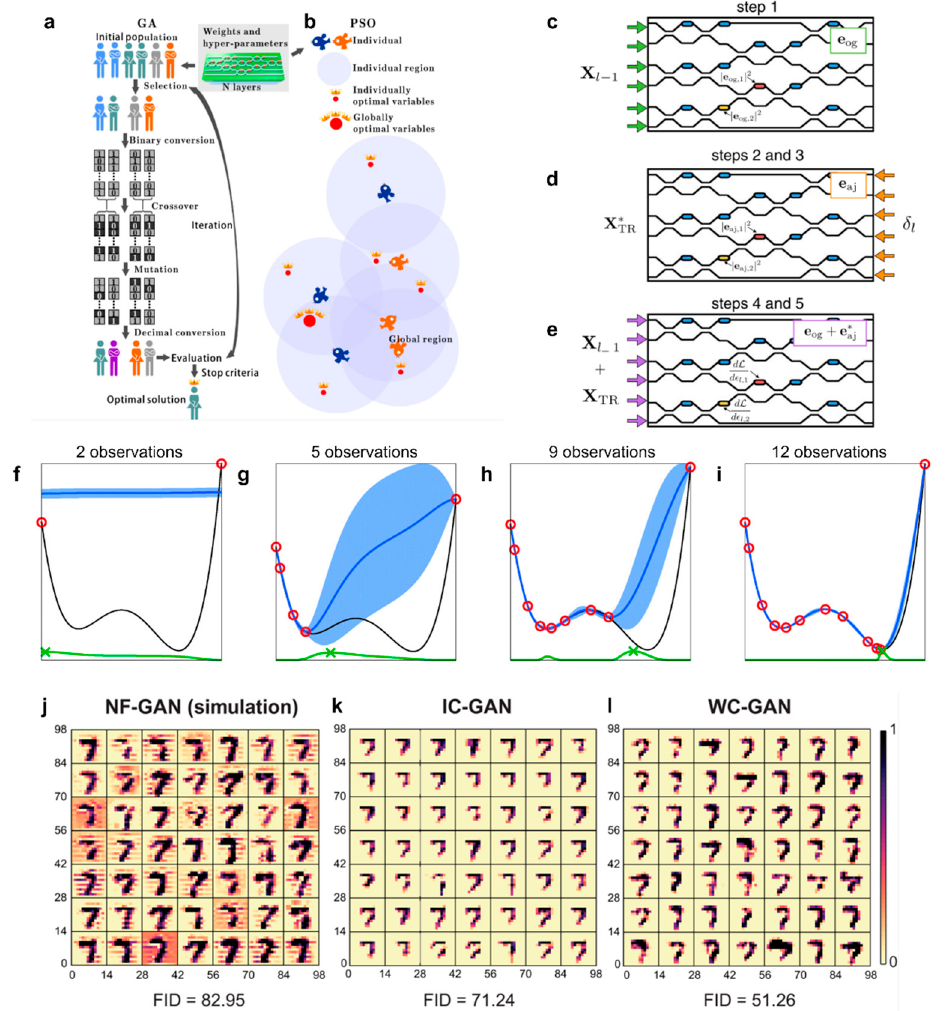
Figure 12. Algorithm . ( a ) The flowcharts of the learning algorithms for the ONNs based on GA (genetic algorithm) [102]. ( b ) The flowcharts of the learning algorithms for the ONNs based on PSO (particle swarm optimization) [102]. ( c – e ) Schematic illustration of the proposed method for experimental measurement of gradient information [100]. ( f – i ) Illustration of the Bayesian optimization on a toy 1D problem [103]. ( j – l ) Generating handwritten numbers with GAN. ( j ) to ( l ) Forty-nine